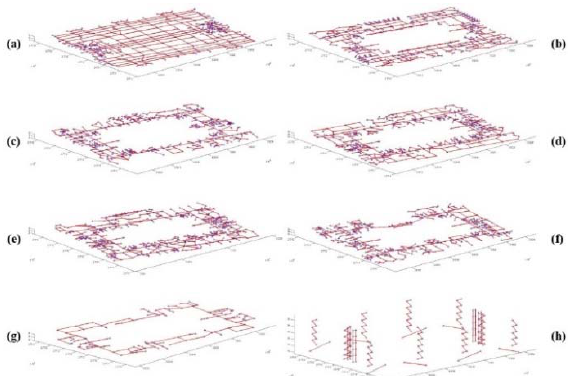
Figure 7. Edited IndoorGML models in different floors